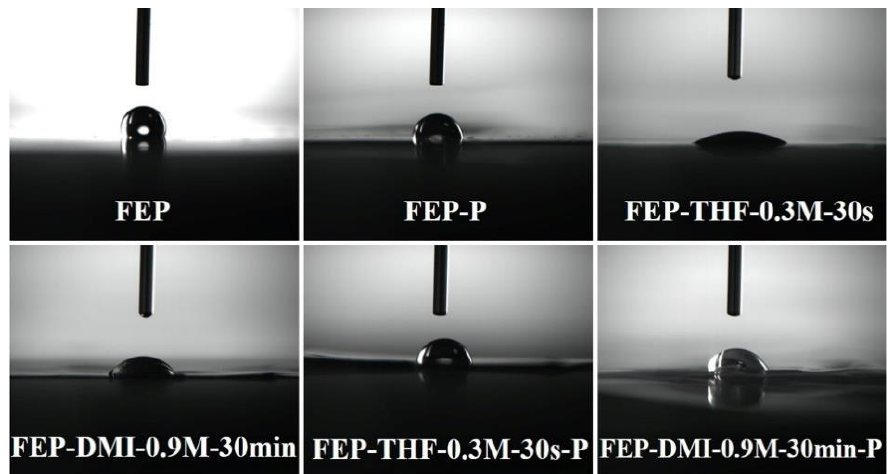
Figure 8. Photographs of the contact angle test for the FEP film with water under different activation conditions.